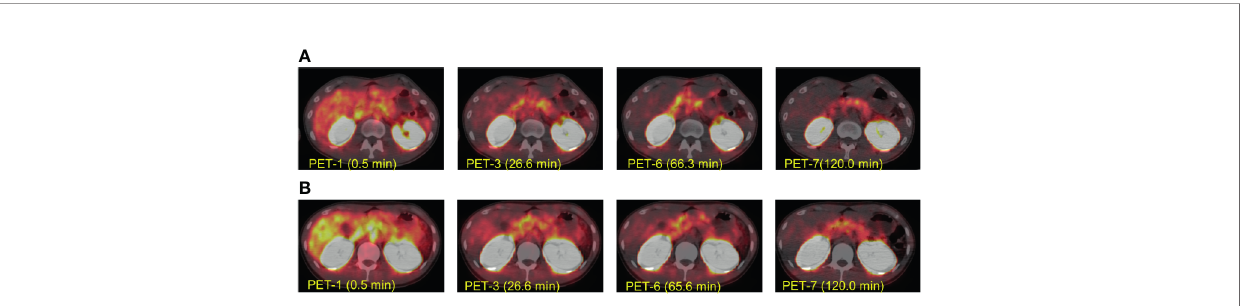
FIGURE 3 | The representative transverse [ 18 F]FB(ePEG12)12-exendin-4 ( 18 F-Ex4) PET/CT images. The transverse [ 18 F]FB(ePEG12)12-exendin-4 ( 18 F-Ex4) PET/CT images of Case 2 (A) and Case 3 (B) . The fi rst PET scan was performed immediately after 18 F-Ex4 administration, and following fi ve-time scans consisting of 2 min/ frame × 5 frames (PET 1 – 6) were undertaken. The fi nal scan was started at 2 h after administration of 18 F-Ex4 (PET 7). The numbers in parentheses indicate the time after 18 F-Ex4 administration.